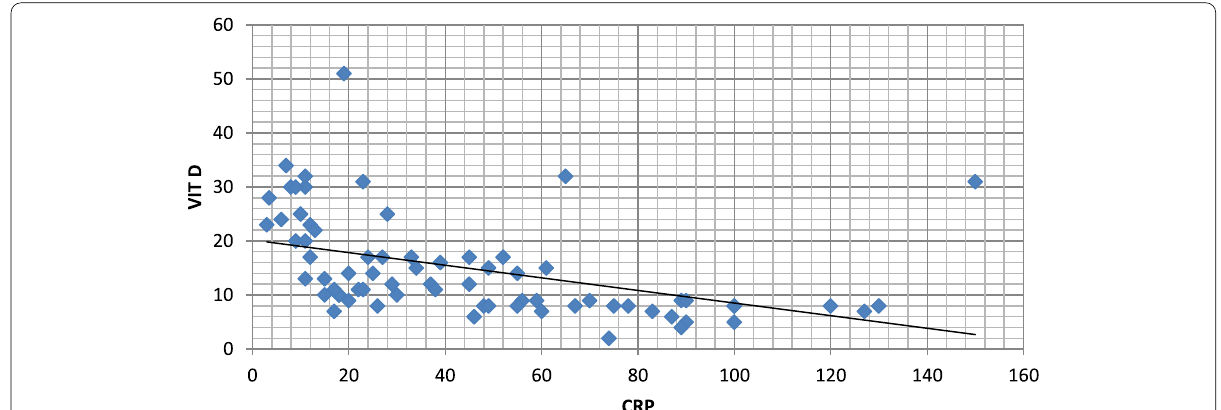
Fig. 24 Correlation between vitamin D and CRP level